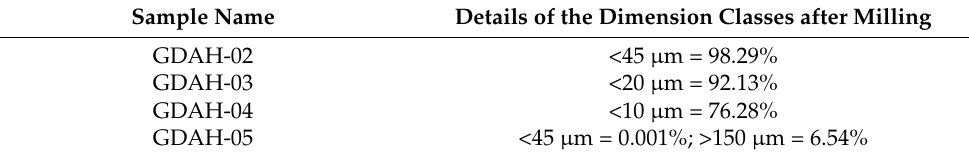
Table 1. Aluminum hydroxide ceramic